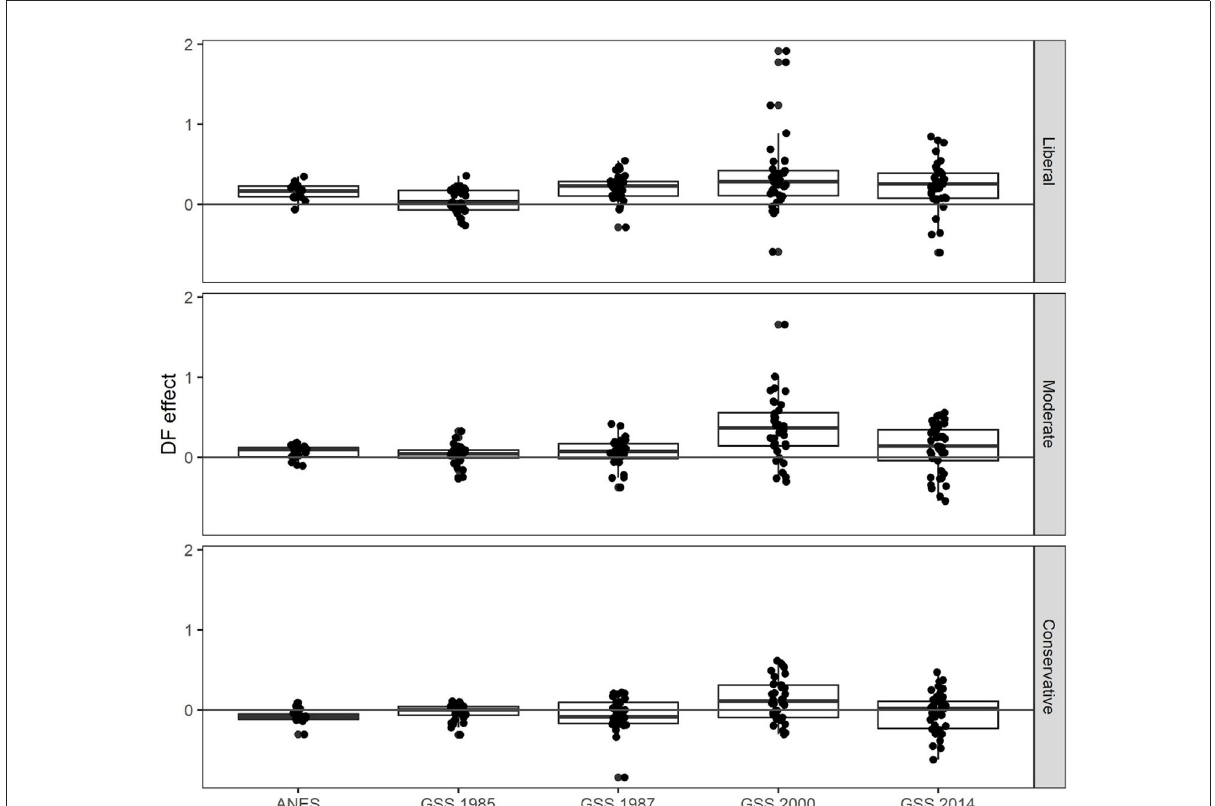
FIGURE4 Liberals who discuss more frequently tend to have more liberal opinions, whereas there is no systematic effect of discussion frequency among conservatives. Boxplots of the discussion frequency effect on opinions among liberals (top), moderates (middle), and conservatives (bottom), estimated for 16 moral issues in the American National Election Studies (ANES) and 52 moral issues in the General Social Survey (GSS) using logistic regressions adjusted for education, gender, age and ethnicity. On the vast majority of issues, higher discussion frequency was associated with a greater probability of holding the liberal (HVFL argument advantaged) opinion among liberals, whereas there was no such tendency among